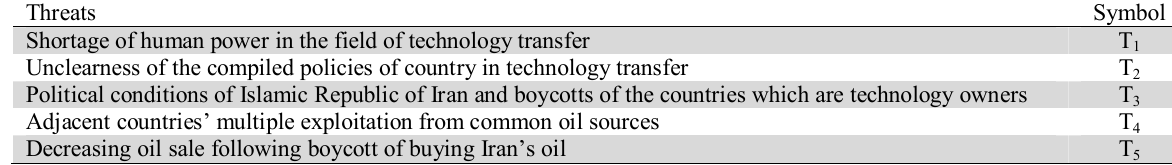
Identified threatens